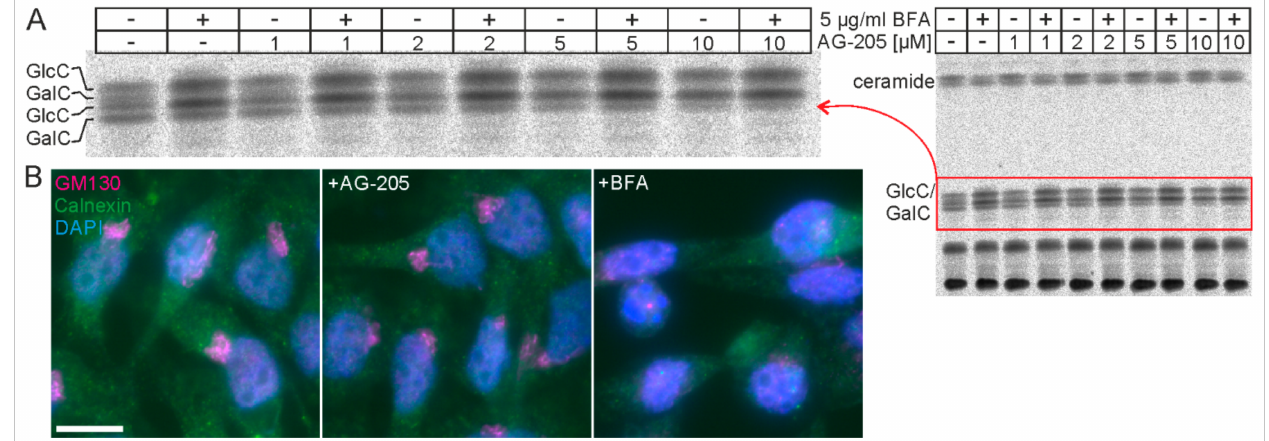
Figure 5. BFA and AG-205 treatment. ( A ) CHO-CGT cells were treated with 5 µ g/mL BFA (+) and increasing concentrations of AG-205 (0 to 10 µ M) for 16 h and then metabolically labelled with [ 14 C]-serine for 6 h. Isolated lipids were separated by TLC. Only the region containing hexosylceramides is shown. ( B ) CHO-CGT cells were treated with AG-205 (10 µ M), BFA (5 µ g/mL), or solvents (DMSO and ethanol) for 18 h followed by immunofluorescence staining of the Golgi marker GM130 (magenta) and endoplasmic reticulum marker calreticulin (green). Nuclei were stained with DAPI (blue). Note the characteristic Golgi staining pattern of GM130 in control cells (left panel) and AG-205 treated cells and its absence in BFA-treated cells. Scale bar, 20 µ m.